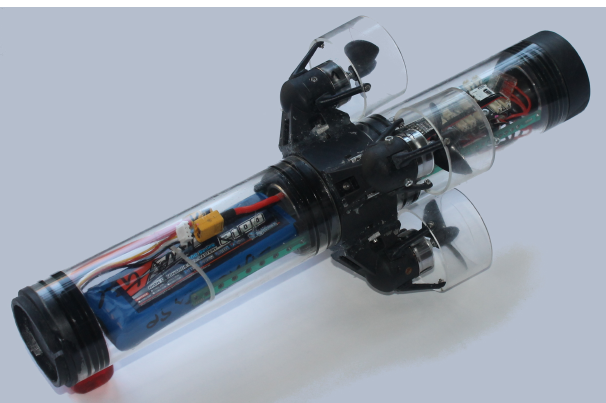
Figure 1. Photo of HippoCampus. A µ AUV which is 35cm long and suitable for multi-robot operations in liquid-filled tanks [2].